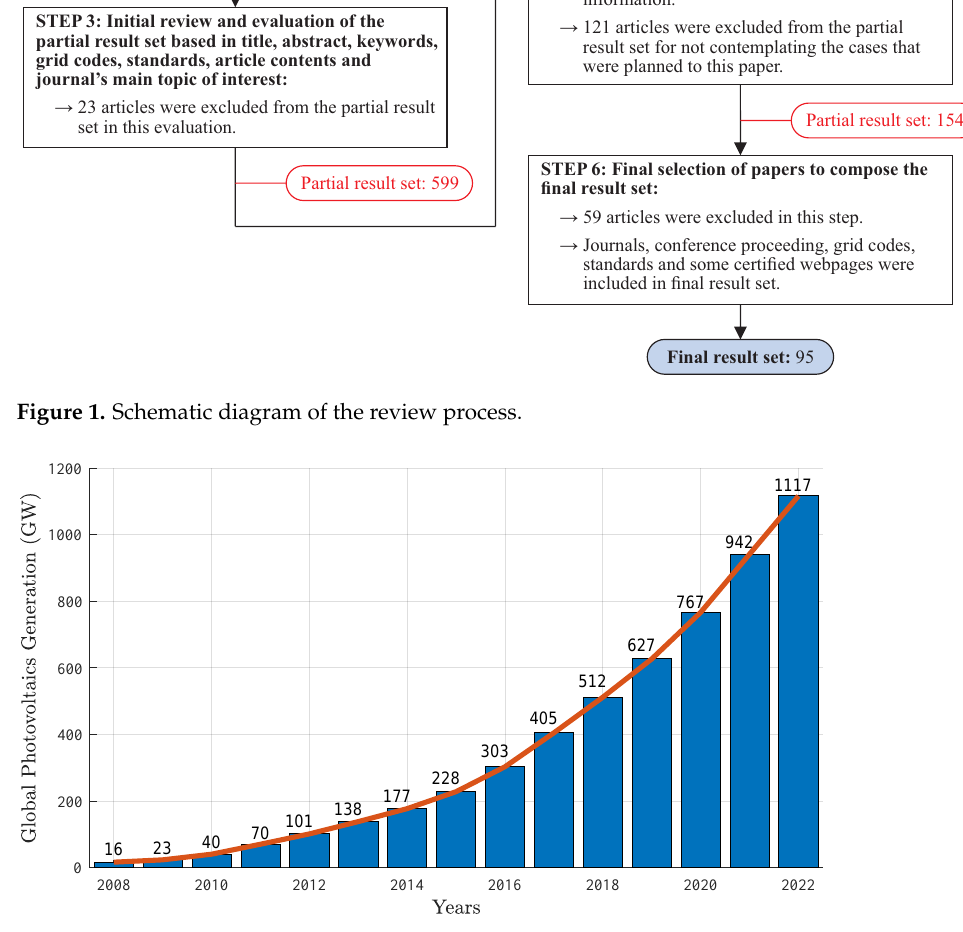
Figure 2. Renewable energy indicators from 2018 to